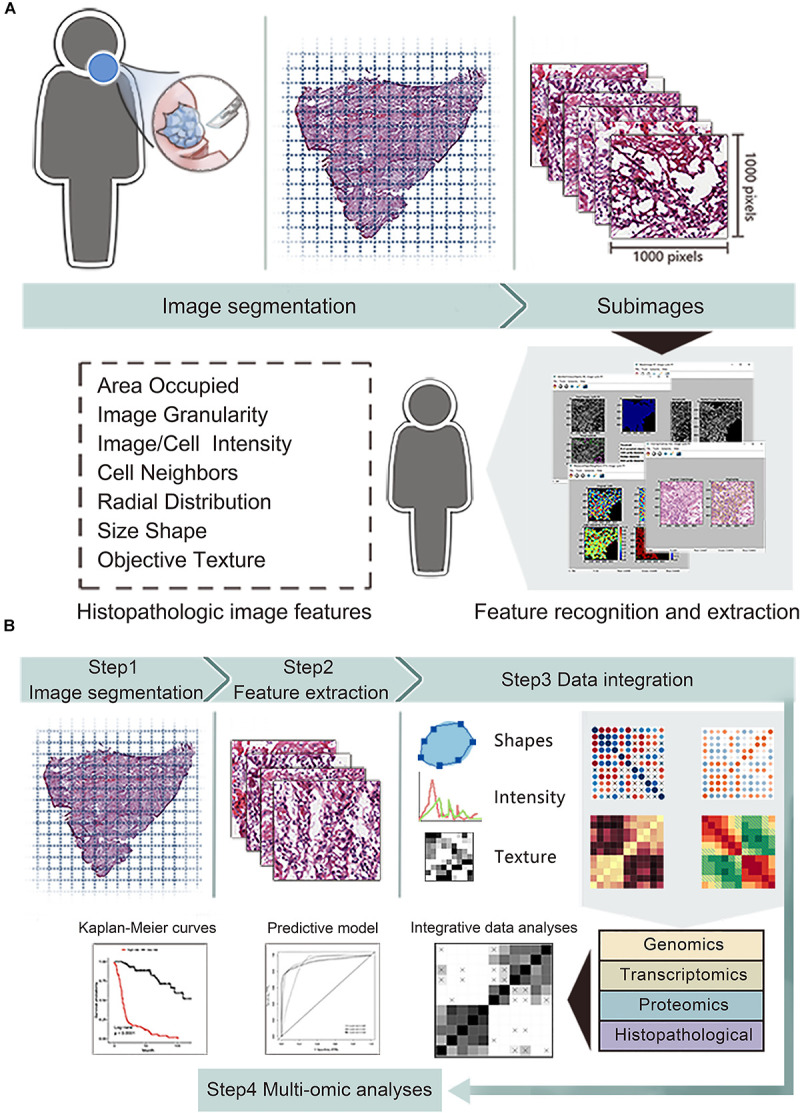
The workflow of data analysis and integration. (A) The whole-slide histopathological images of head and neck squamous cell carcinoma were cropped into small sub-images of 1,000 × 1,000 pixels. Then we excluded the sub-images containing white space more than 50% and selected 20 sub-images for each patient. Next, CellProfiler estimated the images and obtained mean value of image features related to shape, intensity and texture. (B) We integrated features of histopathological images, genomics, transcriptomics and proteomics to generate improved prognostic models by random forest method with in training set, then evaluated the model predictive performance in validation set.